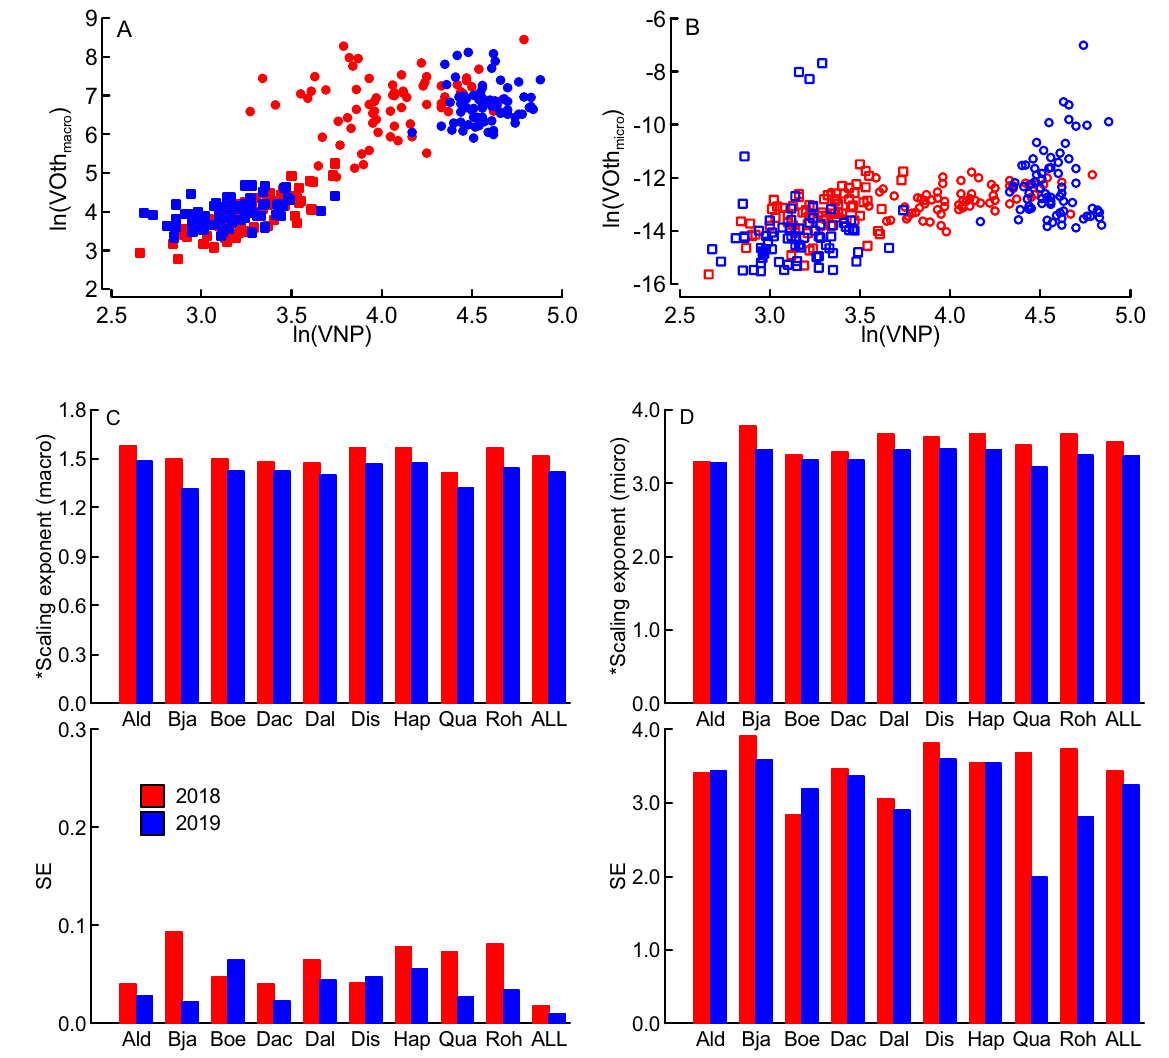
Figure 2. Scatter plots of the volumes (natural logarithm) of plant N and P concentrations (VNP) versus the volumes of other elements (VOth) at tillering (circles) and flowering (squares) ( A macroelements, closed symbols; B microelements, open symbols); and the corresponding scaling exponents (means and standard errors, SE, from 4 replicates; C , D ) for nine wheat varieties field-grown in Sweden during two years (2018 red, 2019 blue). Data from two soil compaction treatments were included, but not separately presented as no significant differences were found between them. ( A, C ) VOth = macroelements (Ca, K, Mg, S) and ( B, D ) VOth = microelements (Cu, Fe, Mn, Zn). For the macroelements, the scaling exponents differed significantly between varieties (ANOVA, N = 16, F = 13.87, P < 0.001) and years ( N = 144, F = 23.12, P < 0.001) but not compaction treatments ( N = 144, F = 3.14, P = 0.077); for the microelements, scaling exponents did not significantly differ between varieties, years or treatments (ANOVA, P > 0.05). Varieties Ald ‘Alderon’, Bja ‘Bjarne’, Boe ‘Boett’, Dac ‘Dacke’, Dal ‘Dala landrace’, Dis ‘Diskett’, Hap ‘Happy’, Qua ‘Quarna’, Roh ‘Rohan’; ALL indicates the means and SE across all varieties. * indicates scaling exponents based on data from tillering (BBCH29) and flowering (BBCH65) 35 . N = 288 in (A) and (B), where the data represent individual